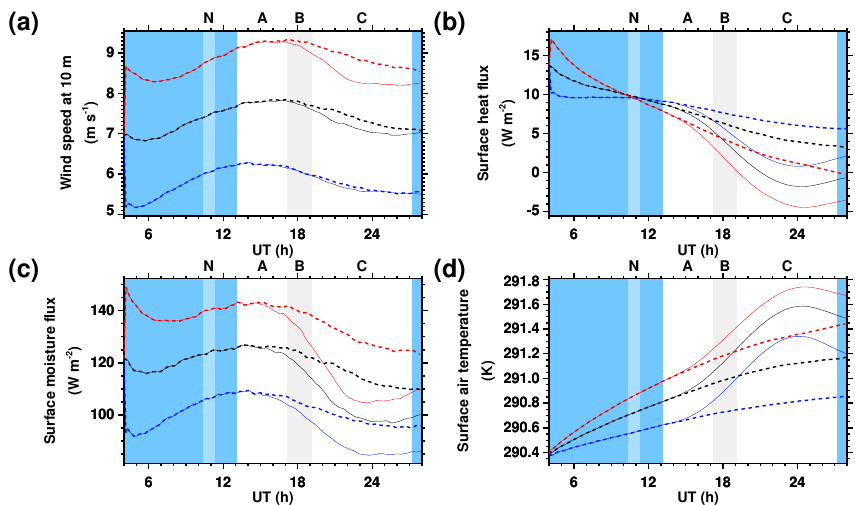
Figure 5. Wind speed and the diurnal cycle. Time series from simulations M − (blue), M 0 (black), M + (red), solid curves, and from simulations M − (blue), M 0 (black), M + (red), dashed curves. Blue shading indicates nighttime. The time periods A, B, C, and N are dark dark dark highlighted to facilitate the